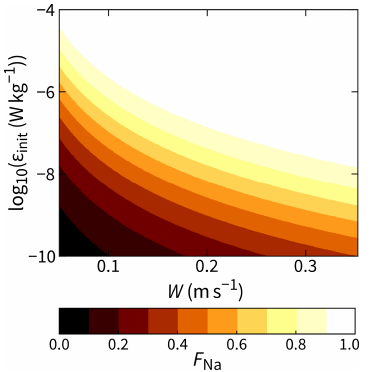
Figure 2. The correction function F Na for ν = 1 × 10 − 6 m 2 s − 1 and f l – f h =